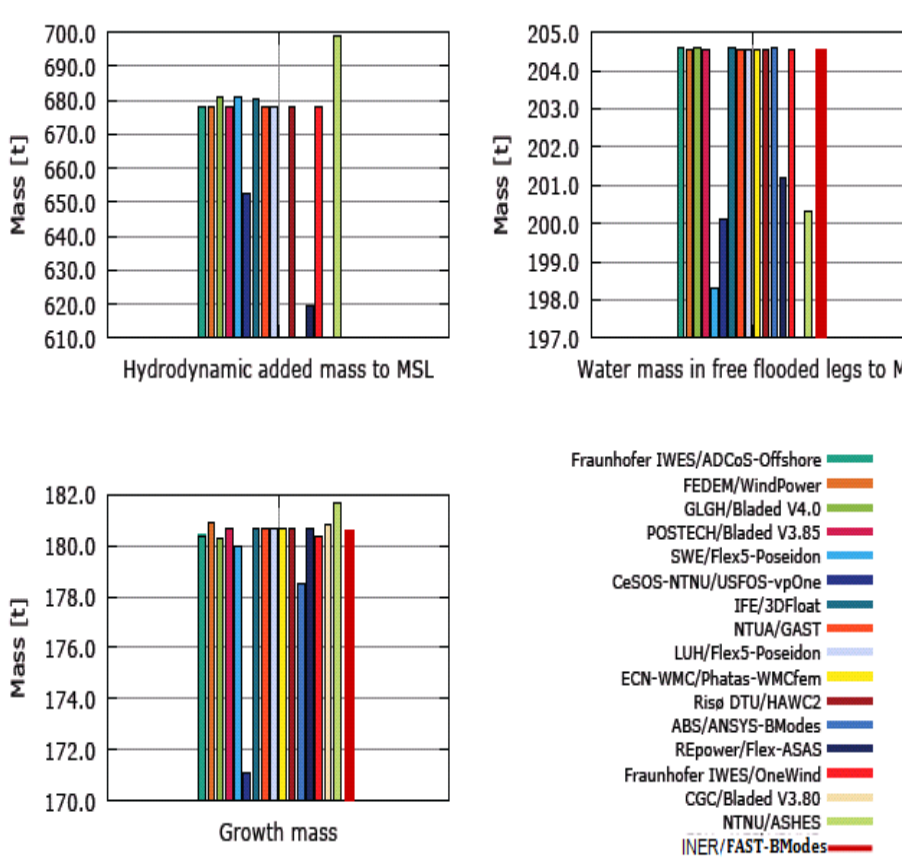
Figure 10. Additional Mass Loadings. MSL: Mean Sea Level Table 3. Marine growth conditions [21].